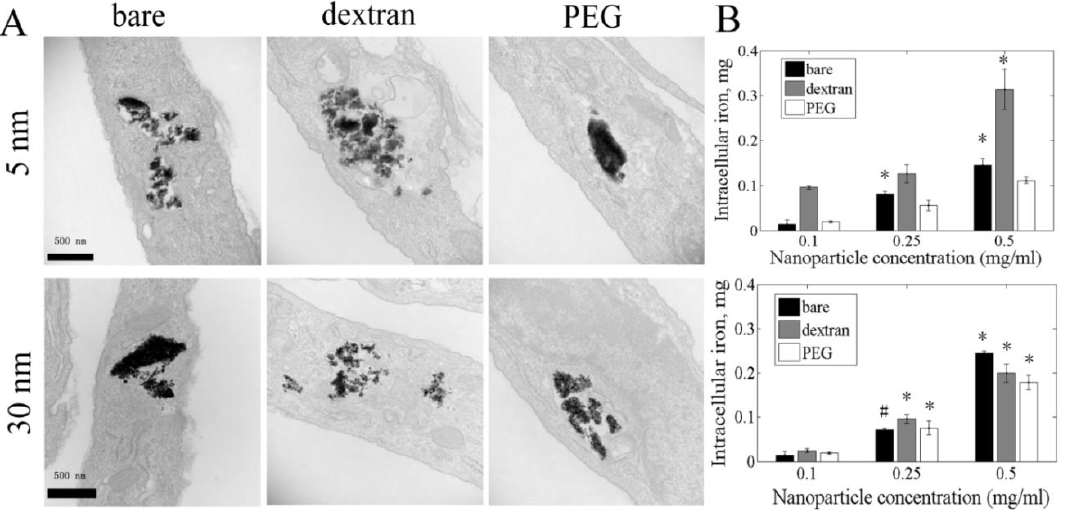
Figure 2. Iron oxide nanoparticles were taken into cells after 3 h incubation. ( A ) Porcine aortic endothelial cells (PAEC) were incubated with 0.1 mg/mL bare, dextran or PEG coated iron oxide nanoparticles. Large nanoparticle aggregation was observed in vesicles in the cytoplasm; ( B ) Intracellular iron increased with nanoparticle concentration, as measured by iron absorbance. * p < 0.01 compared to 0.1 mg/mL for same coating condition, # p < 0.05 compared to 0.1 mg/mL for same coating condition.